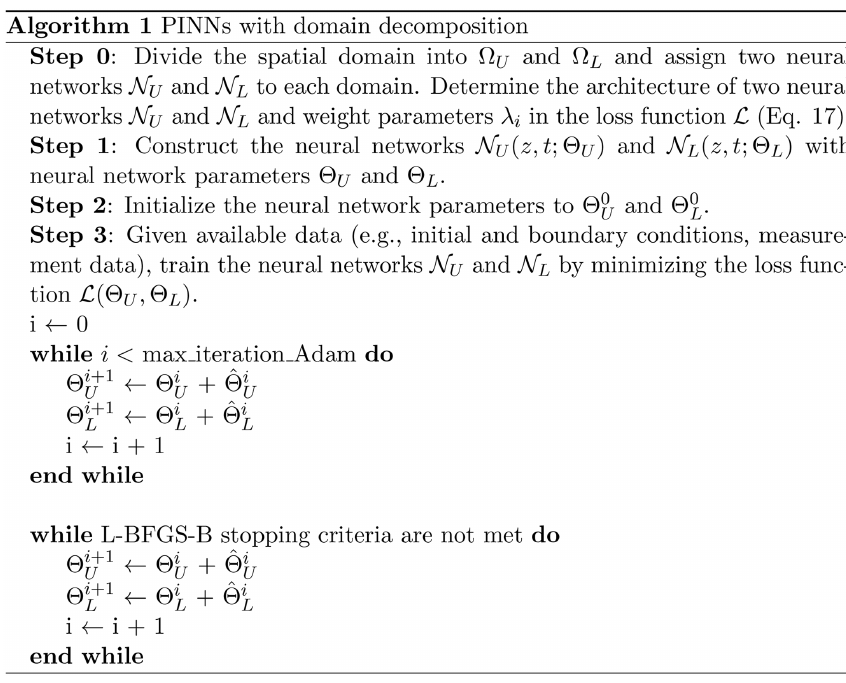
Figure 2. The algorithm for PINNs with domain decomposition for a two-layered soil. (cid:127) U and (cid:127) L refer to the spatial domain for the upper and lower layers, respectively. In Step 3, max_iteration_Adam is the maximum number of the Adam iteration (set to 100000 in the study); ˆ (cid:50) represents the update for the neural network parameter (cid:50) ; L-BFGS-B stopping criteria are summarized in Sect.